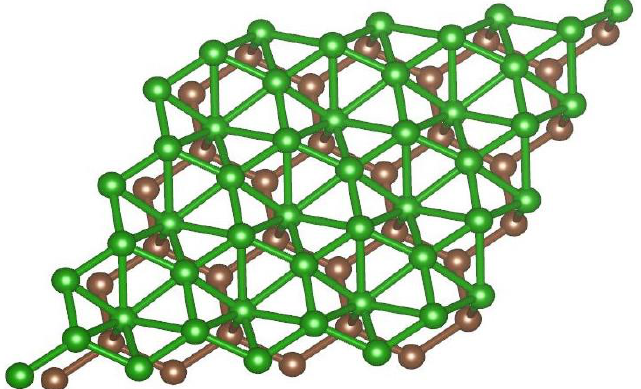
Figure 1. Atomistic model of the borophene-graphene bilayer. Green and brown balls represent boron and carbon atoms, respectively.